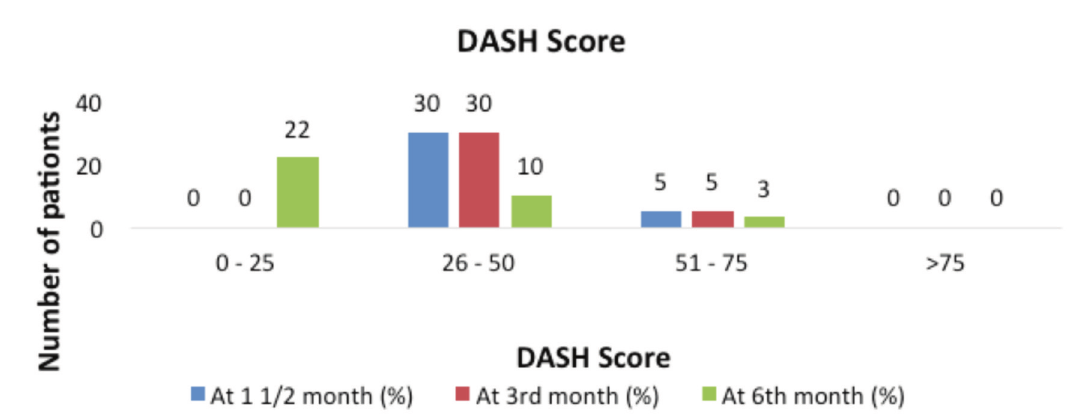
Distribution of DASH score Fig. 4: